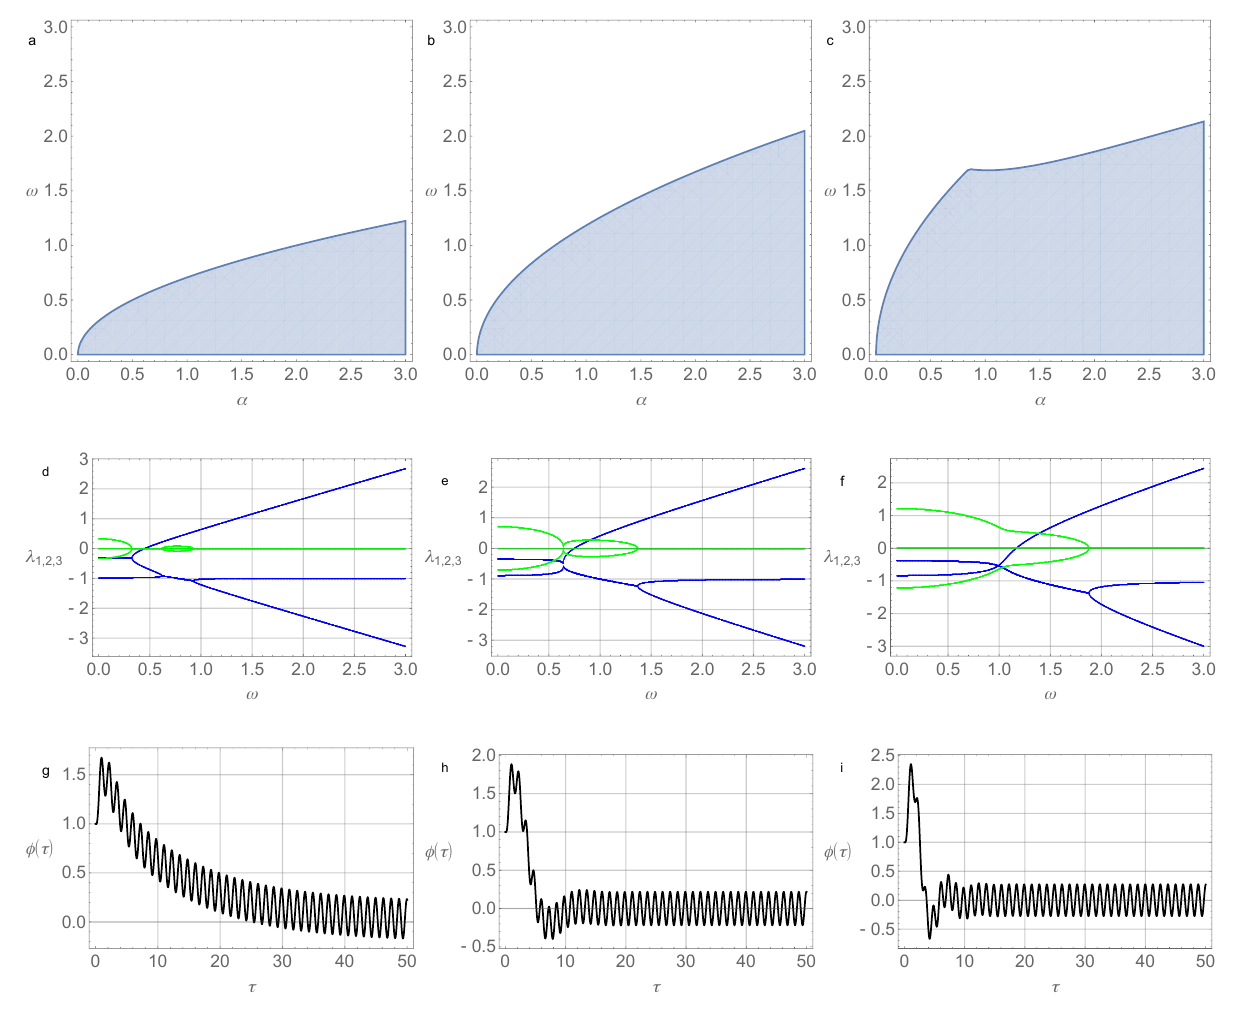
Figure 2. ( a ) System stability area (24) in the ( α , ω ) plane for parameter values σ = 0.05 and γ = 0.2; ( b ) system stability area (24) for parameter values σ = 0.5 and γ = 0.2; ( c ) system stability area (24) for parameter values σ = 1.5 and γ = 0.2; ( d ) real (thick blue lines) and imaginary parts (thin green lines) of the roots of the characteristic Equation (25) for σ = 0.05, γ = 0.2, α = 0.4; ( e ) real (thick blue lines) and imaginary parts (thin green lines) of the roots of the characteristic Equation (25) for σ = 0.5, γ = 0.2, and α = 0.4; ( f ) real (thick blue lines) and imaginary parts (thin green lines) of the roots of the characteristic Equation (25) for σ = 1.5, γ = 0.2, and α = 0.4; ( g ) the angle of pendulum deviation depending on the dimensionless time for σ = 0.05, γ = 0.2, α = 0.4, ω = 0.4, d = 1.0, and Ω = 5.0; ( h ) the angle of pendulum deviation depending on the dimensionless time for σ = 0.5, γ = 0.2, α = 0.4, ω = 0.4, d = 1.0, and Ω = 5.0; ( i ) the angle of pendulum deviation depending on the dimensionless time for σ = 1.5, γ = 0.2, α = 0.4, ω = 0.4, d = 1.0, and Ω = 5.0. Initial conditions in ( g , h , i ) are ϕ ( 0 ) = 1.0, ψ ( 0 ) = 0.0, and v ( 0 ) =